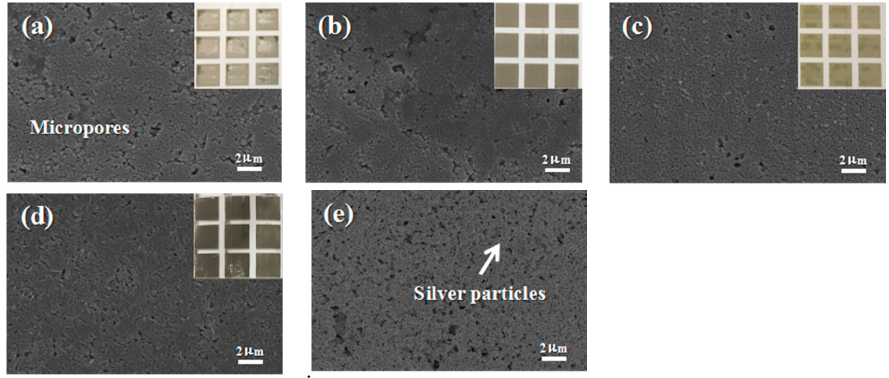
Figure 8. The SEM of the printed Ag patterns using different photo papers as substrates and the surface structure of different photo papers. ( a ) Epson; ( b ) Kodak; ( c ) Fantac; ( d ) Lucky; and ( e ) the Lucky photo paper printed Ag patterns.